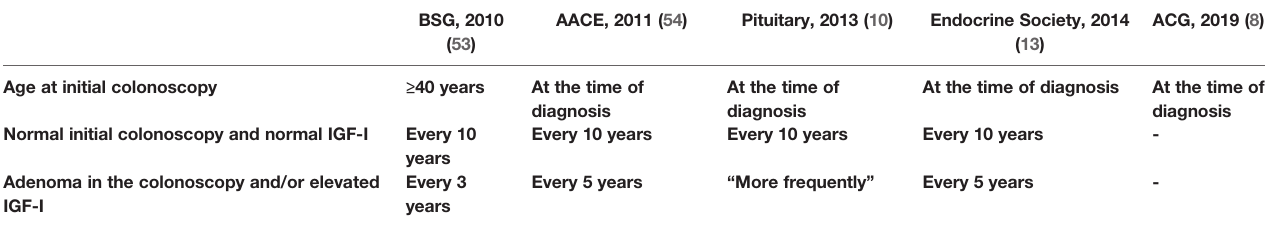
TABLE 2 | Current guideline recommendations for surveillance colonoscopy in